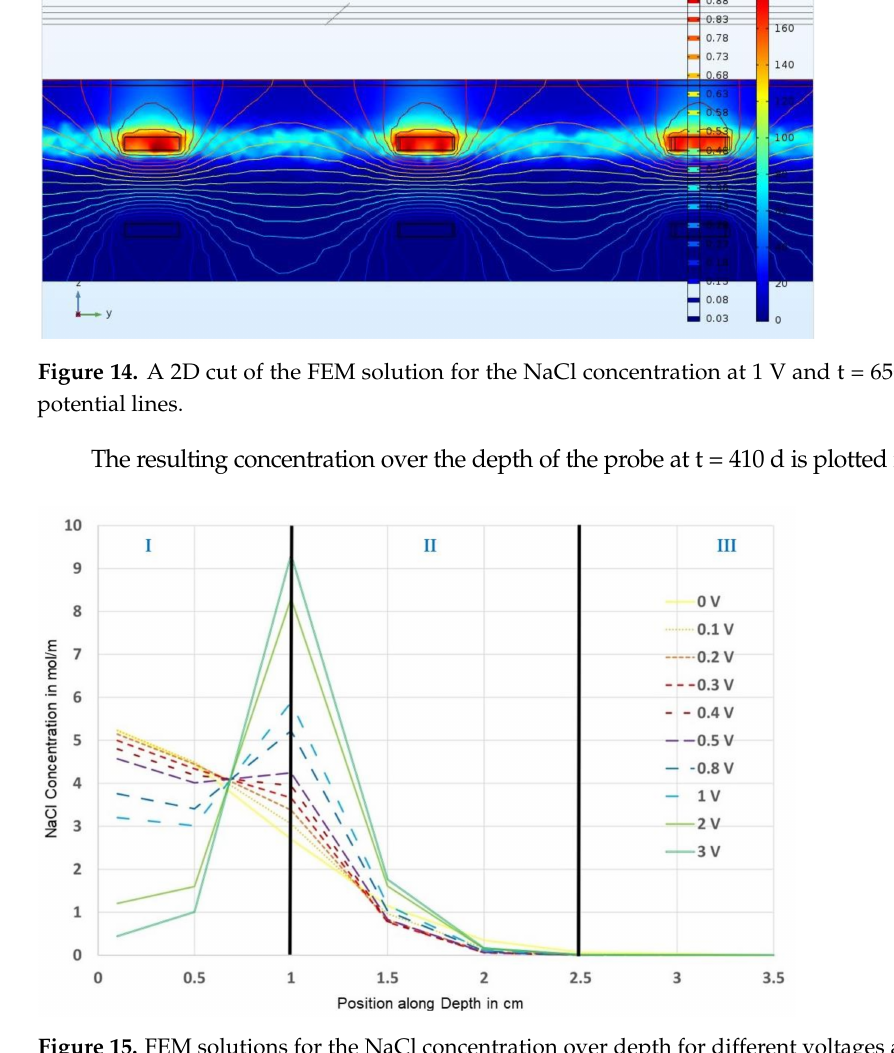
Figure 15. FEM solutions for the NaCl concentration over depth for different voltages at t = 410